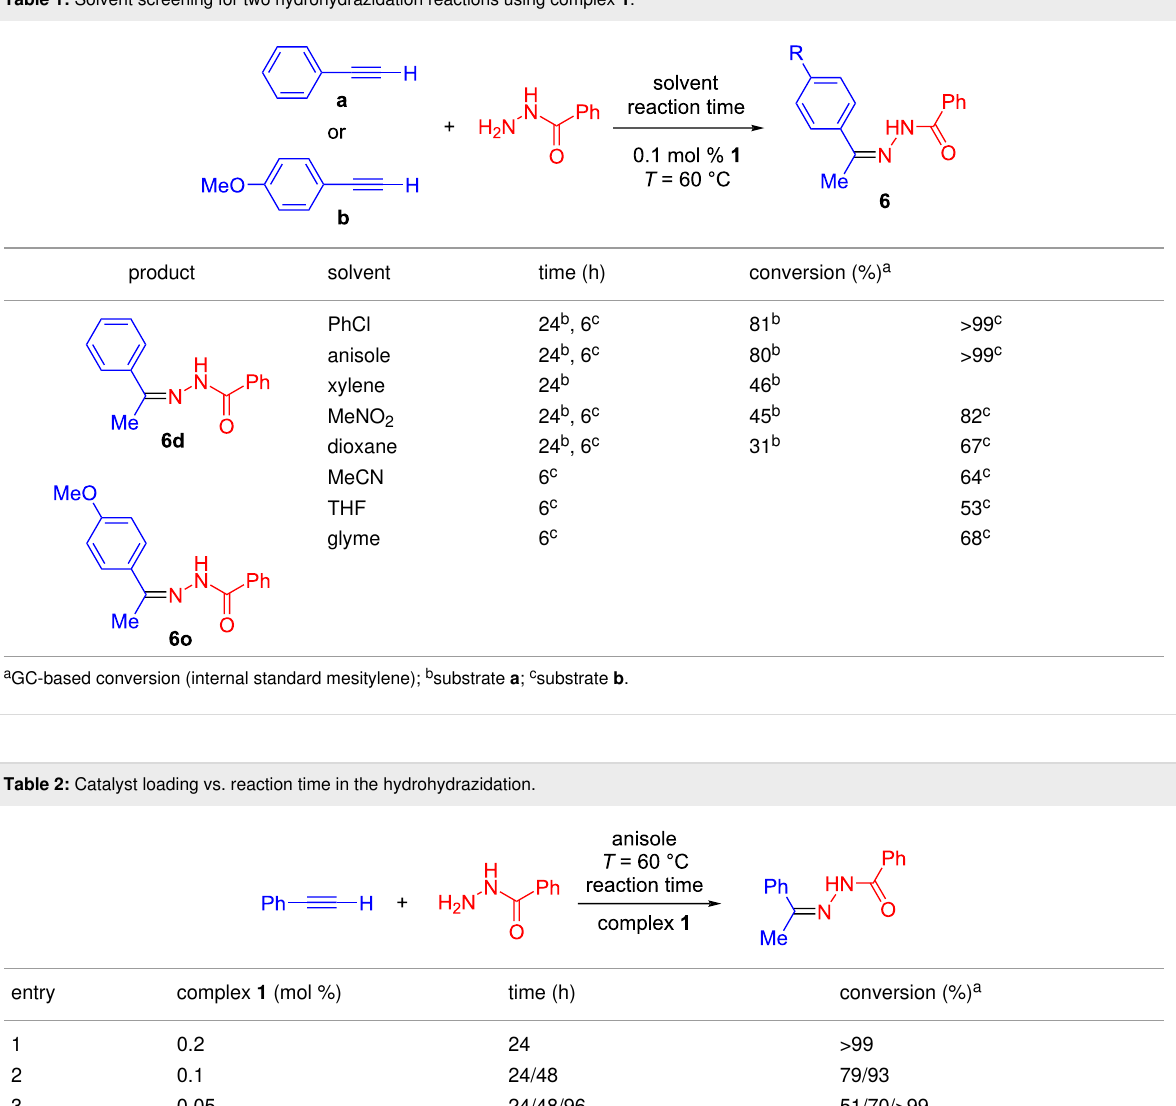
Table 1: Solvent screening for two hydrohydrazidation reactions using complex 1 .